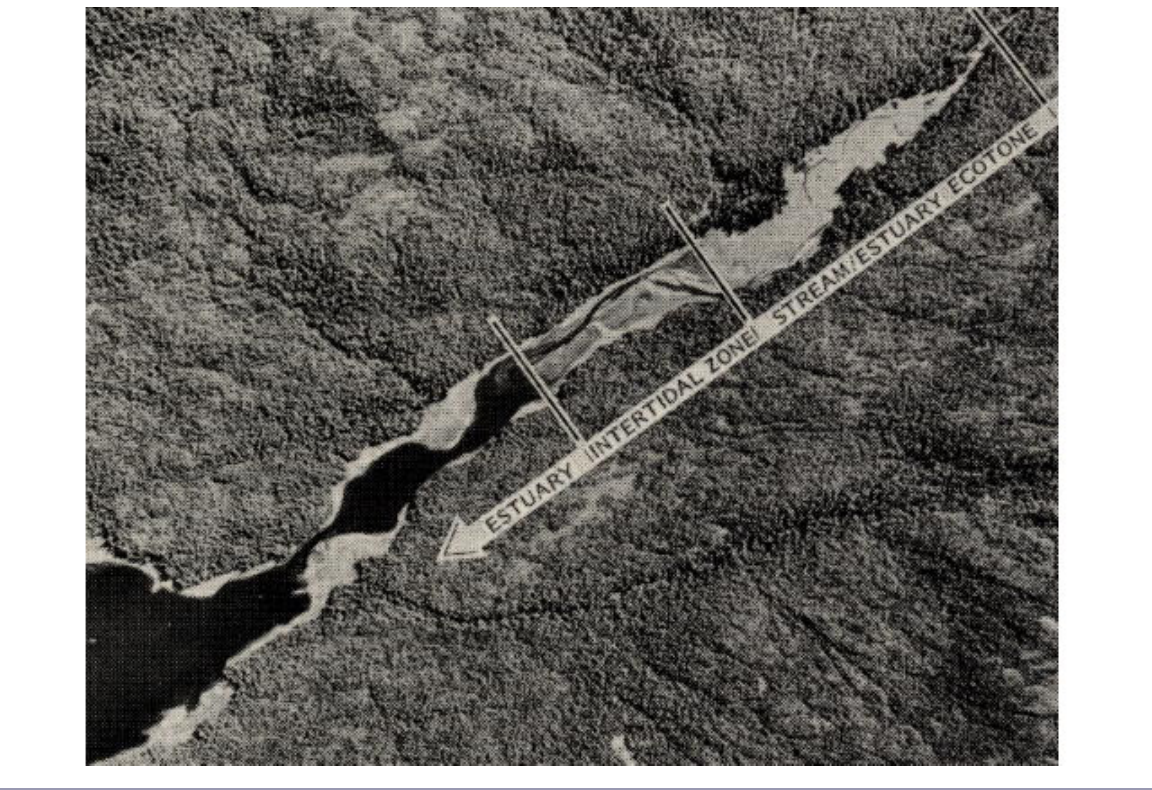
Fig. 1. The ecological zones in a stream and estuarine system showing the boundaries of the stream- estuary ecotone as illustrated for Porcupine Creek in southeast